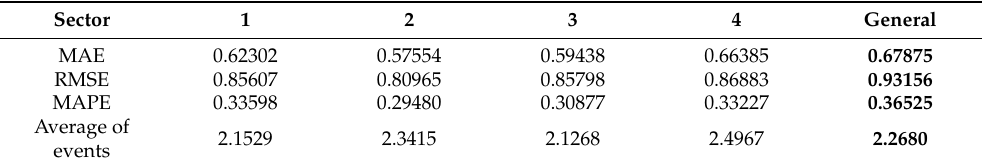
Table 4. Results of the general regression model.